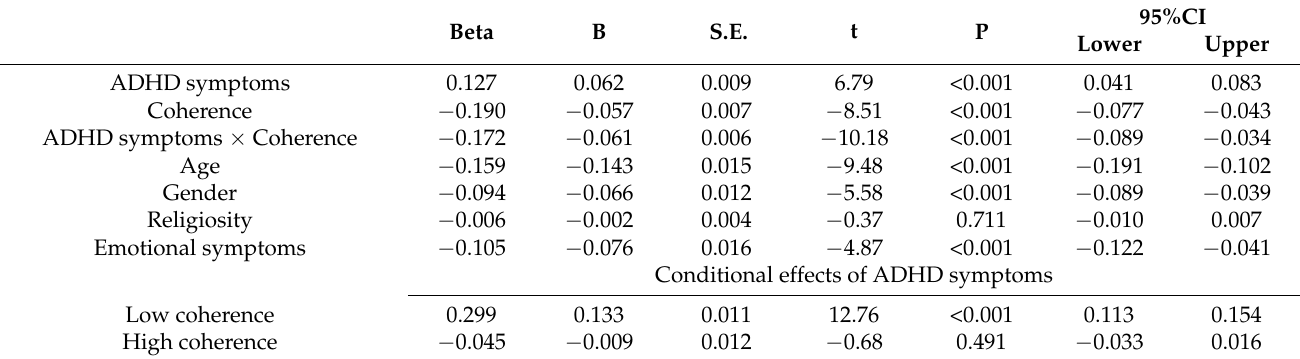
Table 3. ADHD as a predictor of severe physical antisocial behavior moderated by coherence.